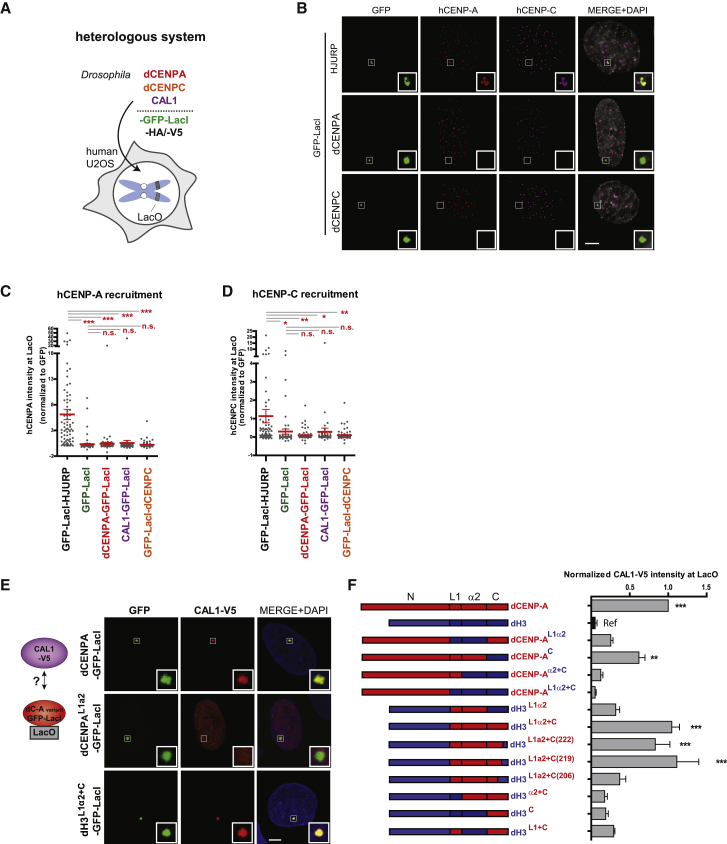
Human and Drosophila Centromere Factors Required for Establishing Centromere Identity Do Not Interfere in the Heterologous System(A) Cartoon illustrating the experimental setup of the heterologous system expressing Drosophila centromere proteins in human cells.(B) Representative IF images used to quantify hCENP-A and hCENP-C recruitment to LacO arrays by HJURP (pos. control) and Drosophila centromere factors fused to GFP-LacI in U2OS cells.(C and D) Quantitation of normalized hCENP-A (C) and hCENP-C (D) mean intensities at LacO upon tethering the indicated proteins fused to GFP-LacI. Insets show magnification of the boxed regions. Scale bar, 5 μm. Error bars show SEM (∗p < 0.05; ∗∗p < 0.01; ∗∗∗p < 0.001; n.s., not significant).(E) Experimental scheme and representative IF images of CAL1-V5 recruitment to the LacO arrays by GFP-LacI-tagged dCENP-A, dCENP-AL1α2, and dH3L1α2+C in U2OS cells.(F) Quantitation of CAL1-V5 mean intensity at LacO upon tethering of the indicated GFP-LacI-tagged chimeras, normalized to its mean intensity at LacO upon tethering of GFP-LacI-tagged dCENP-A. (See also Figure S1.)Error bars show SEM. Asterisks denote significant differences (∗∗p < 0.01; ∗∗∗p < 0.001); absence of an asterisk denotes a non-significant difference. Insets show magnification of the boxed regions. Scale bar, 5 μm. The reference sample for statistical analysis is indicated as Ref.